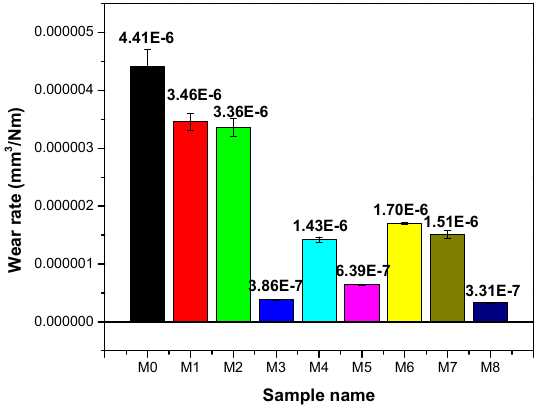
Figure 7. Wear rates calculated for each one of the employed samples.